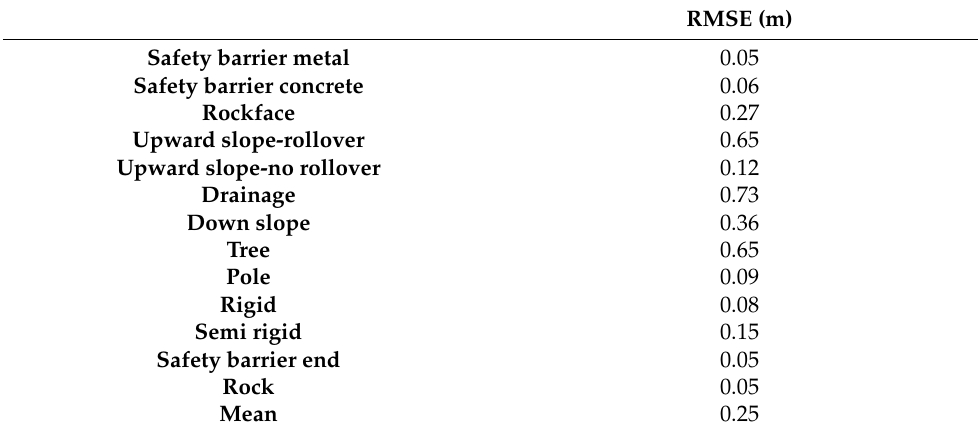
Table 4. RMSE value for every RSS–O class.